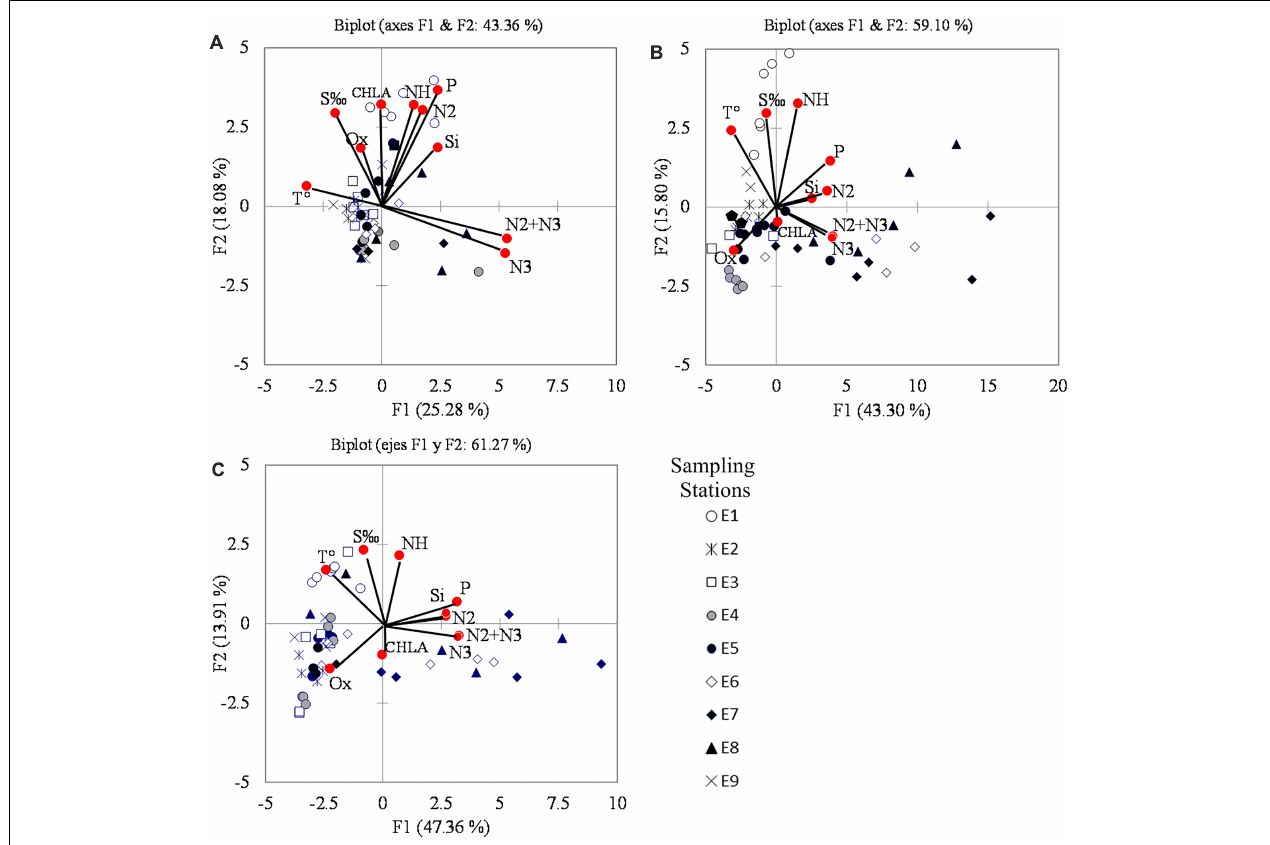
FIGURE 6 | Principal components analysis (PCA) ordination biplots, and location of the sampling sites. (A) 2015; (B) 2016; (C) 2017. The markers show the sampling stations according to Figure 1 . Variables key: T ◦ , temperature; S CHLA, chlorophyll- a